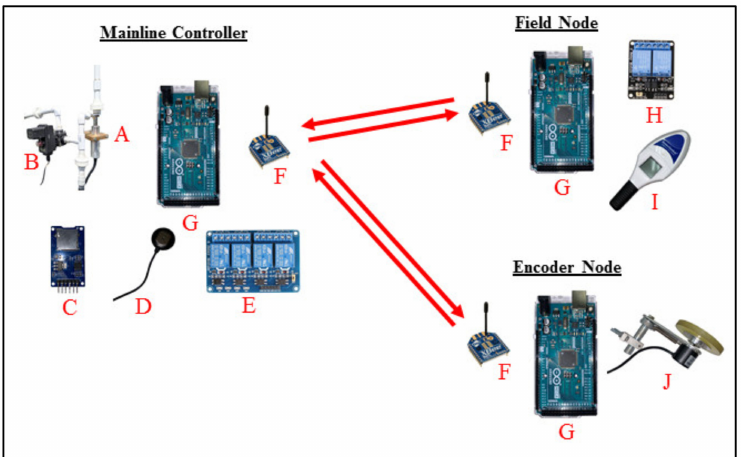
Figure 5. The major components of the electronic control system. ( A ) flow meter, ( B ) the flow control valve, ( C ) an SD card module, ( D ) a GPS receiver, ( E ) a four-channel relay module, ( F ) an XBee radio, ( G ) an Arduino Mega microcontroller, ( H ) a two-channel relay module, ( I ) a Trimble handheld GreenSeeker, and ( J ) a rotary